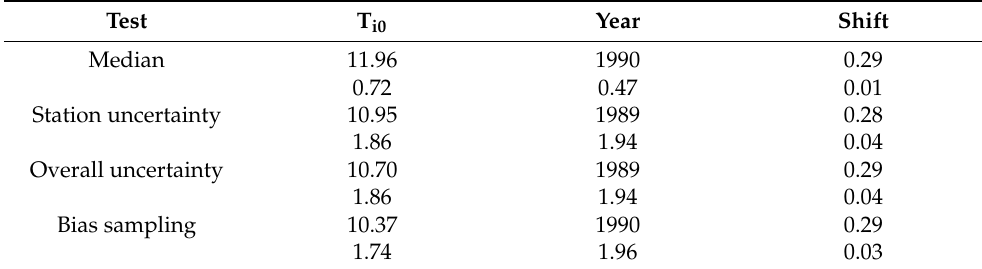
Table 4. Estimates of shifts for an example regime change using different sampling strategies for structural uncertainty for global mean relative humidity (%) over land 1973–2001, showing the change and standard deviation. All changes are p < 0.01.